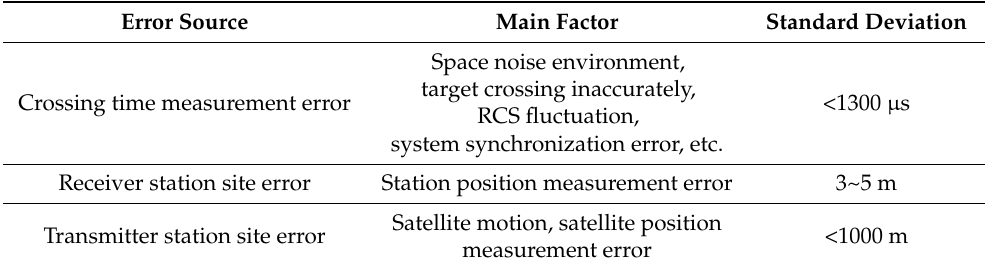
Table 2. Systematic errors. Error Source Main Factor Standard Deviation Space noise environment, target crossing inaccurately, Crossing time measurement error <1300 µ s RCS fluctuation, system synchronization error, etc. Receiver station site error Station position measurement